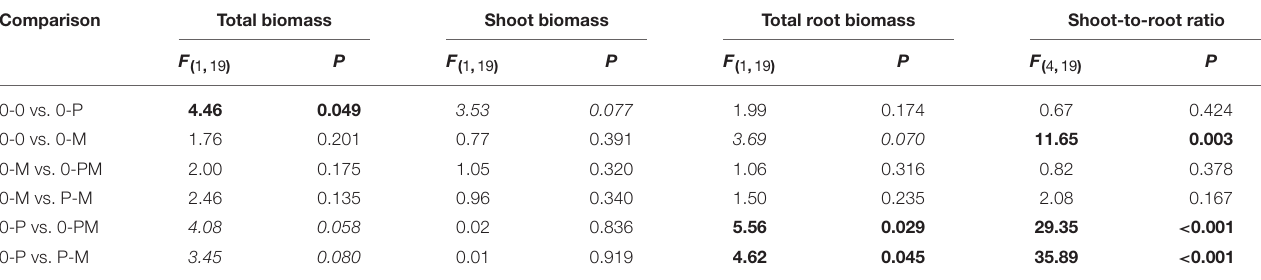
TABLE 1 | F - and p -values of GLM contrasts showing treatment effects on total plant biomass, shoot biomass, biomass of the total root system, and shoot-to-root ratio of Triticum aestivum . Comparison Total biomass Shoot biomass Total root biomass Shoot-to-root ratio